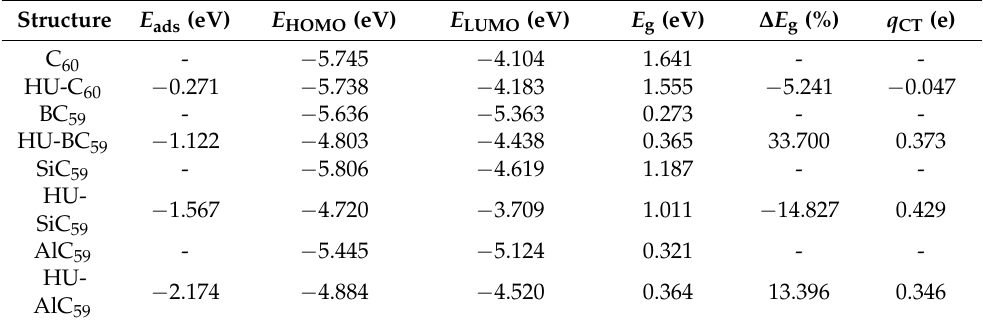
Figure 2. Optimized structures of C 60 ( a ) and HU-C 60 ( b ). All distances are in Angstrom. ( c ) The charge density difference (CDD) of HU-C 60 . The isosurface value is 0.03 a.u. In the CDD plot, the blue and yellow colors correspond to the electron density gain and loss regions, respectively. Table 1. Calculated adsorption energy ( E ads ), HOMO energy ( E HOMO ), LUMO energy ( E LUMO ), HOMO-LUMO gap ( E g ), the change of E g after the HU adsorption ( ∆ E g ), and charge transfer from the HU to fullerene ( q CT ) of the structures in gas